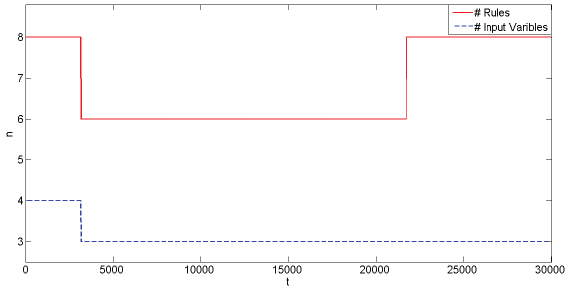
Figure 5. Structure evolution and variable selection of X- eNFN-AFS for the MagLev system.